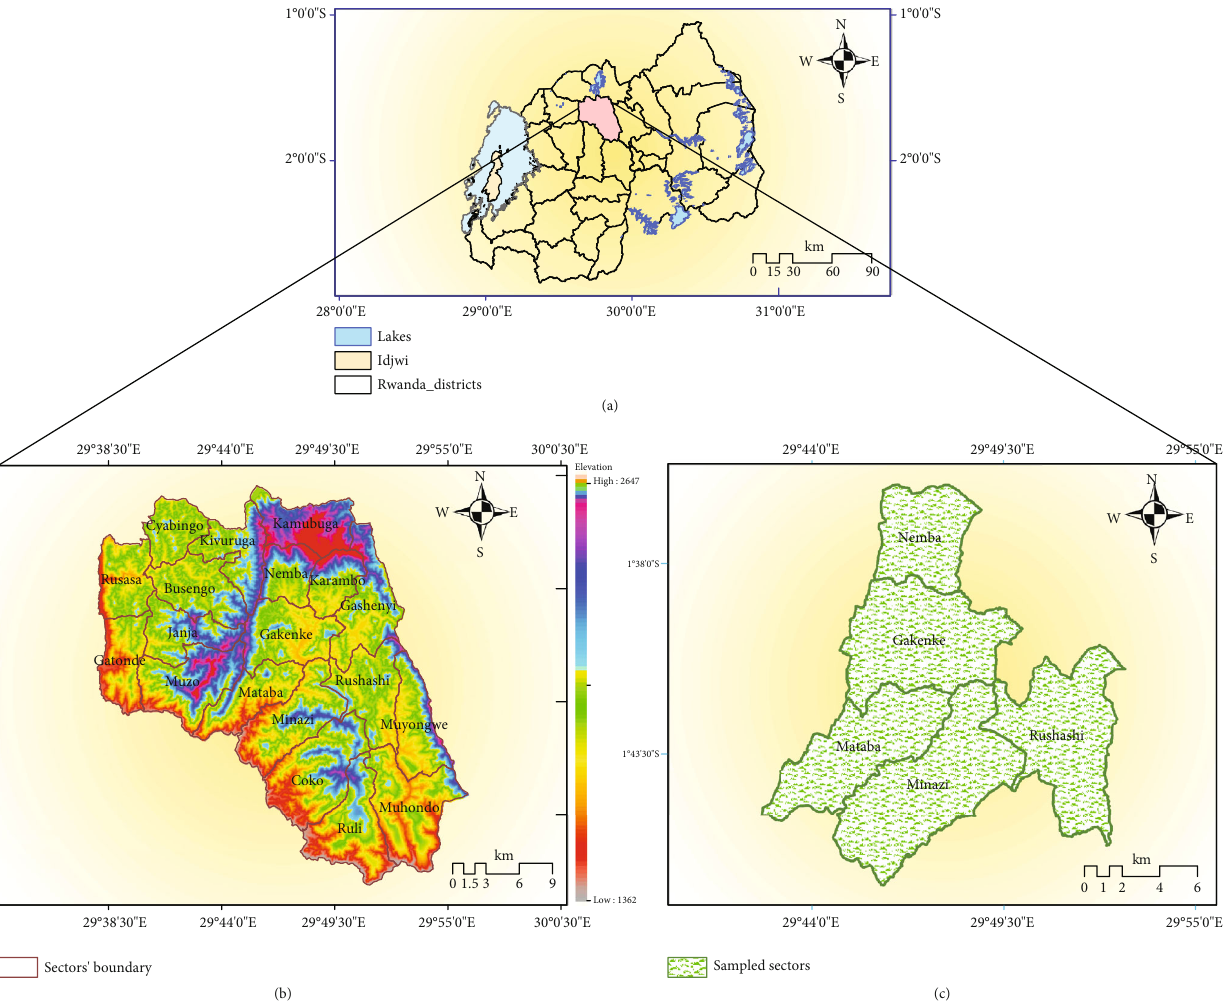
Figure 1: Study area: (a) Rwanda, (b) district elevation map and sectors ’ boundaries, and (c) district ’ s sectors of